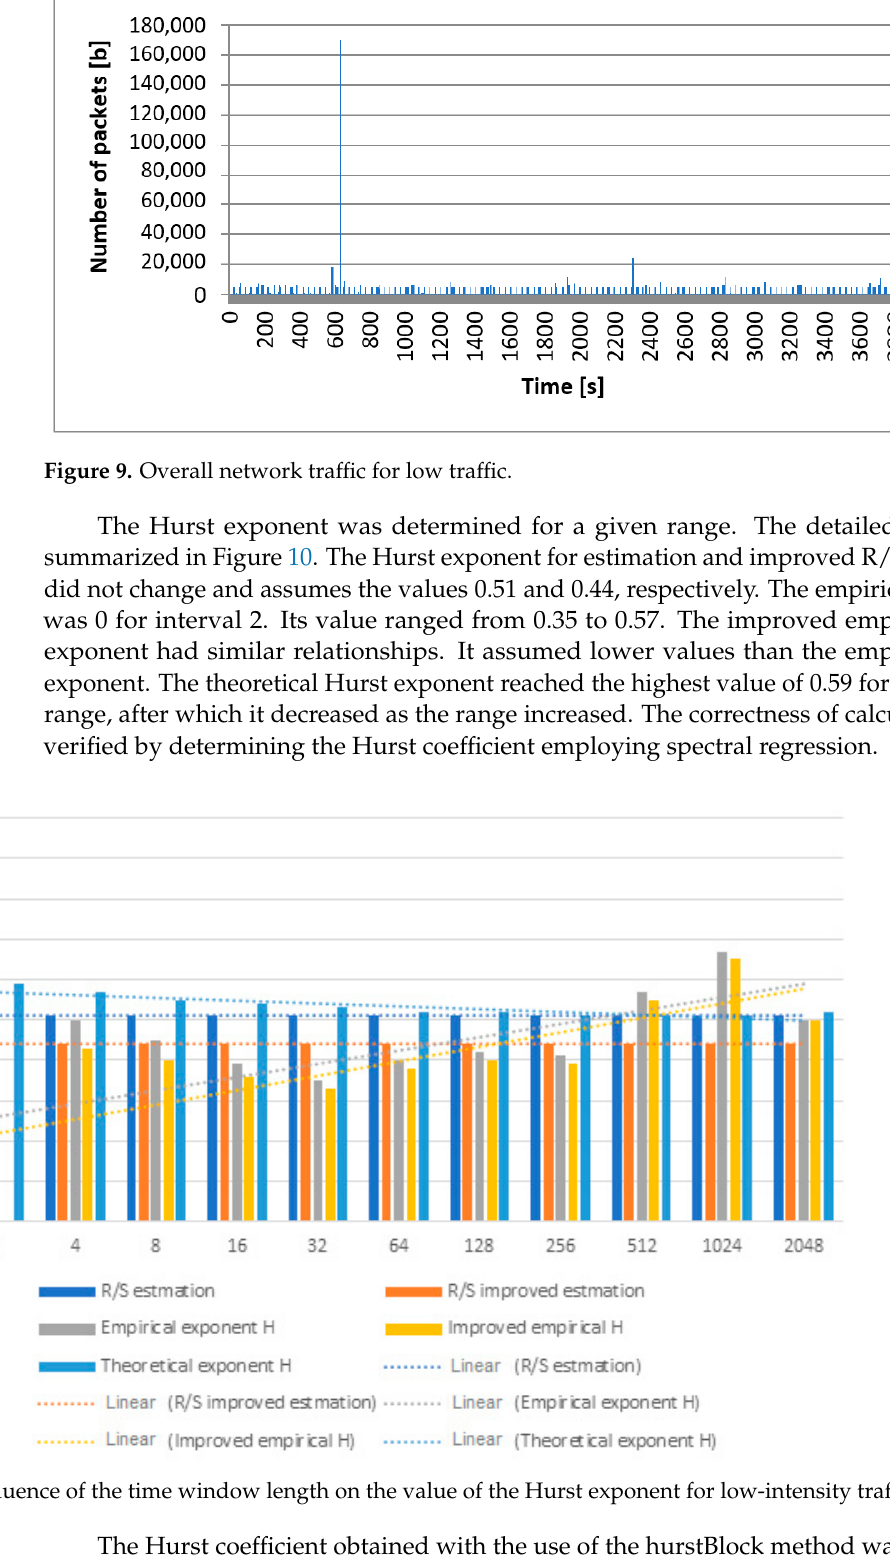
Figure 10. The influence of the time window length on the value of the Hurst exponent for low-intensity traffic.